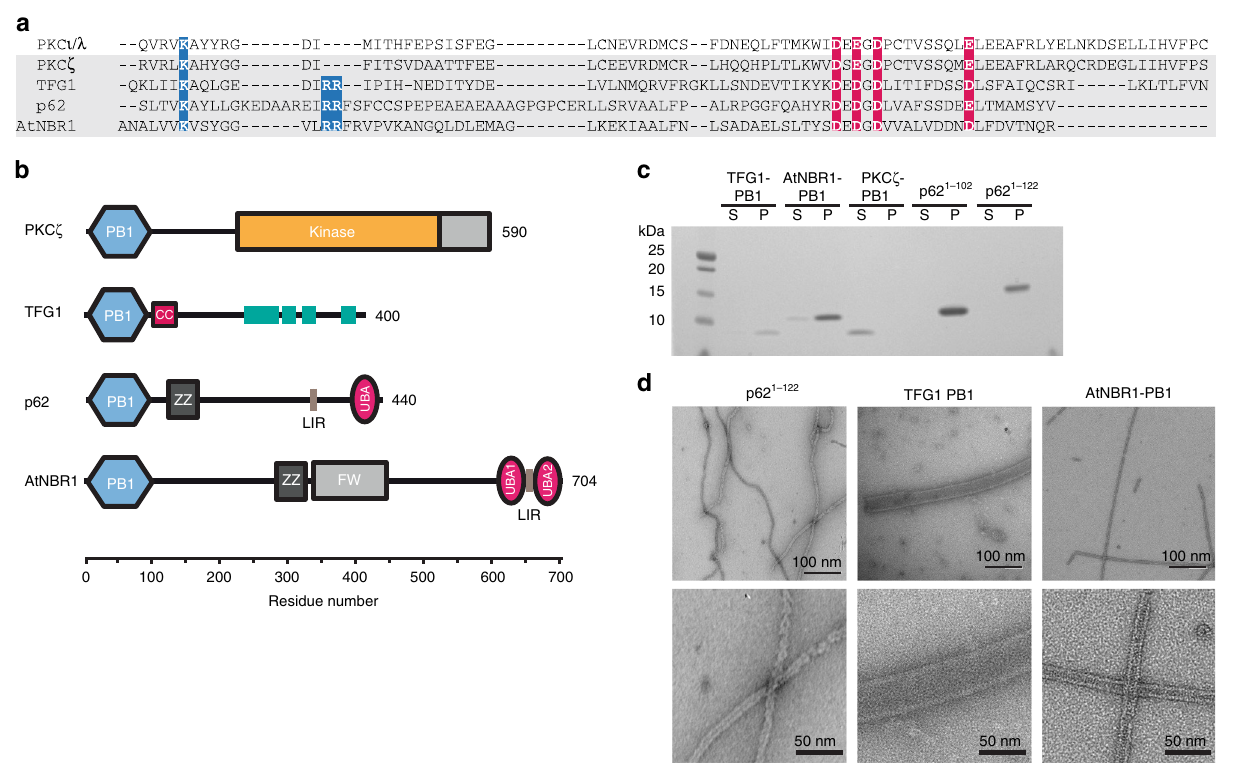
Fig. 1 Type A/B PB1 domains and their capability to form polymers. a Sequence alignment of the type A/B PB1 domains with highlighted tandem arginine motif (blue) in addition to basic (blue) and acidic residues (red). b Domain architecture of PKCz, TFG1, p62, and AtNBR1 proteins. c Pelletation assay of puri fi ed type A, B, or AB PB1 domains: TFG1, AtNBR1, PKC ζ , p62 1 – 102 , and p62 1 – 122 . Corresponding lanes of soluble (S) and pellet (P) fraction are shown. Only PKC ζ remains soluble, whereas TFG1, AtNBR1, and p62 are found in the pellet. Source data are provided as a Source Data fi le. d Electron micrographs of negatively stained specimens reveal elongated fi lamentous p62 1 – 122 , tubular polymers of TFG1 and AtNBR1 of 145 ± 5, 900 ± 52, and 120 ± 4 Å nm in diameter,